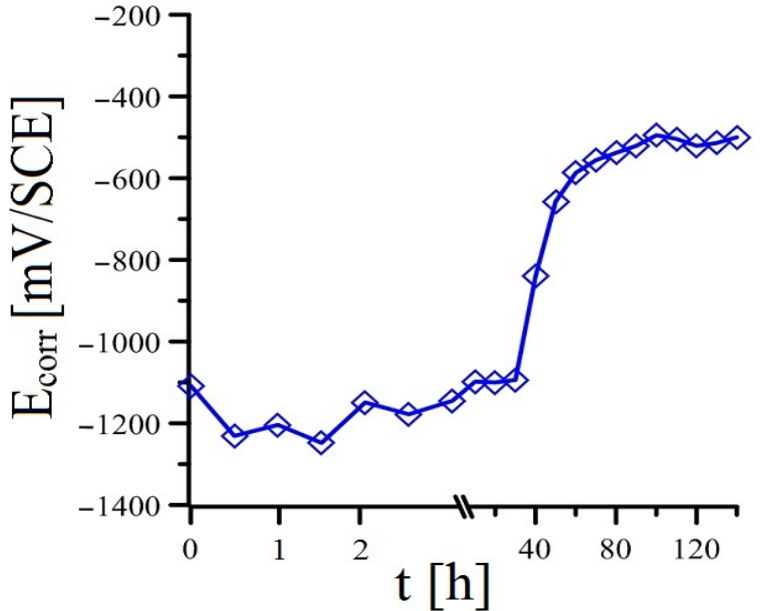
Figure 5. Evolution of open-circuit potential (E corr ) in samples of HDG steel in concrete without addition of MnO 4 − —(mean values).